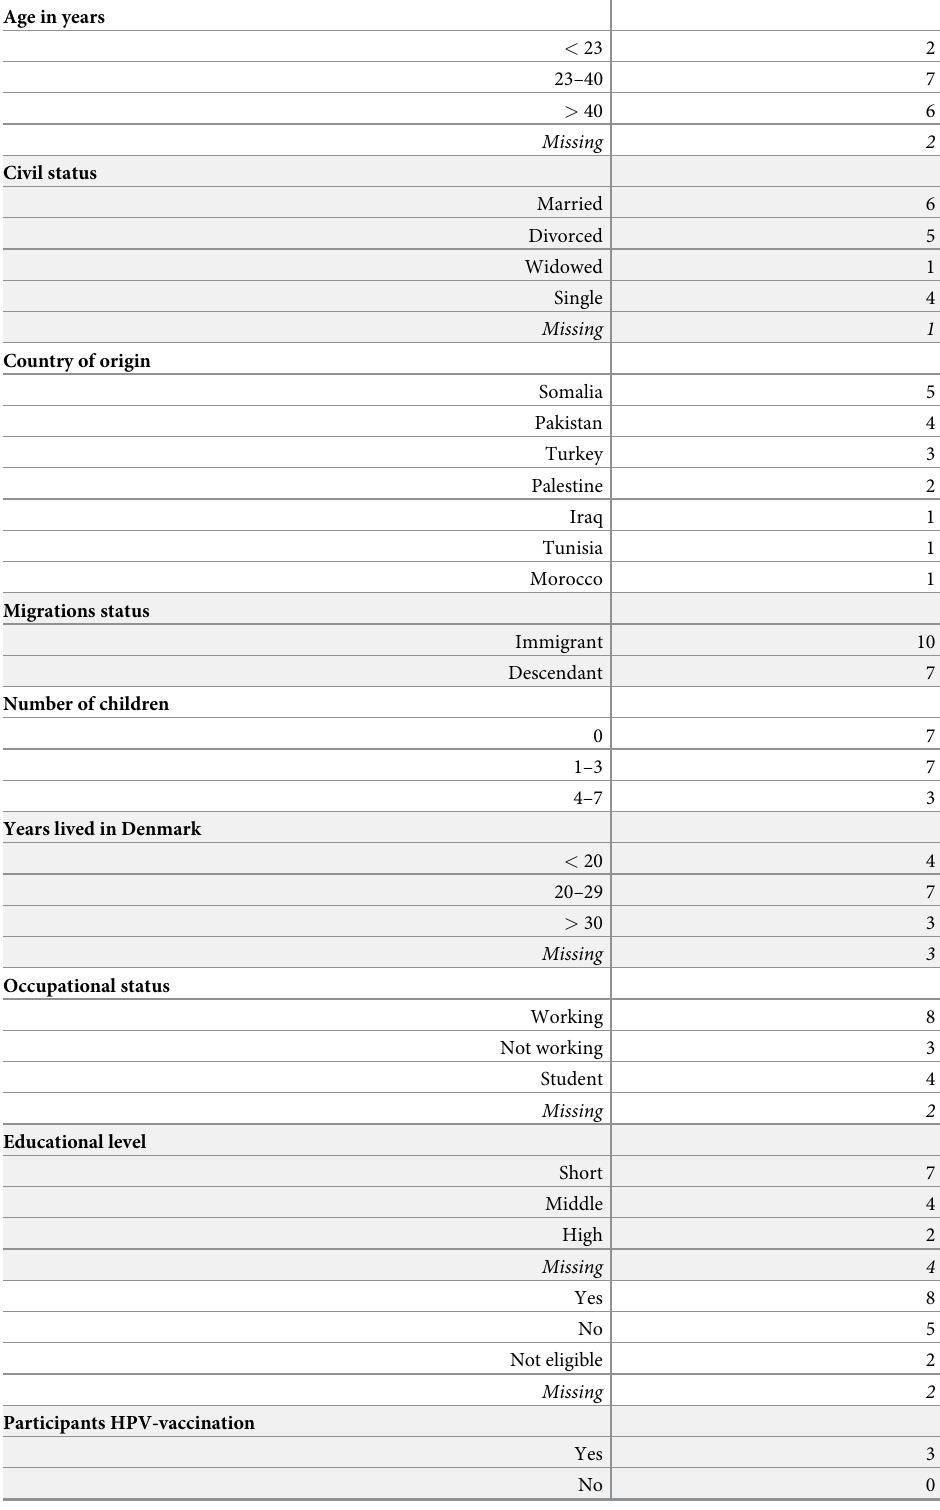
Table 3. Self-reported background characteristics of the FGI